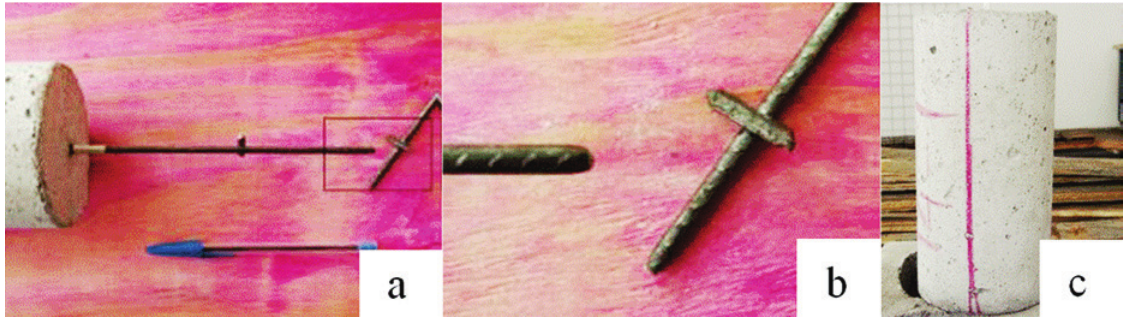
Nota: armadura rompida fora do CP (a, b) sem alteração do cilindro de concreto (c) Figura 7 Modo de ruptura da amostra AT1